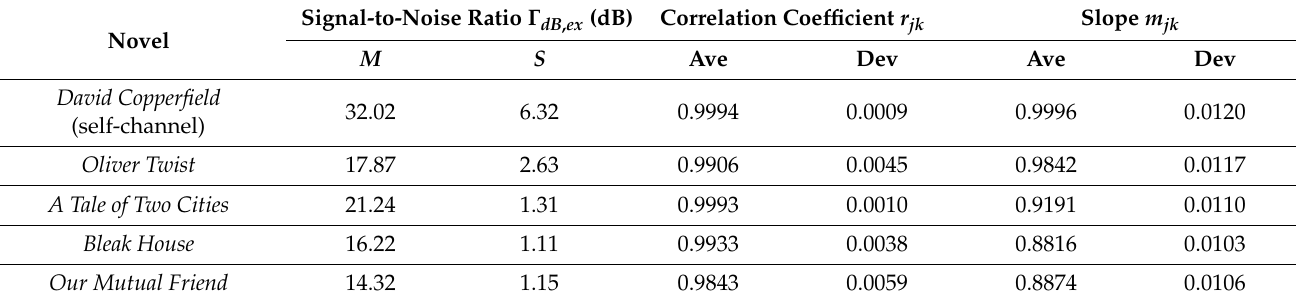
Table 6. Average value M (dB) and standard deviation S (dB) of Γ dB , ex (dB) in self- and cross-channels, correlation coefficient r jk , and slope m jk of the regression line between the number of sentences n S of David Copperfield (channel output, self-channel) versus the number of sentences n S in the other Dickens novels (channel input, cross-channels), for equal number of words, in the sentences channel.